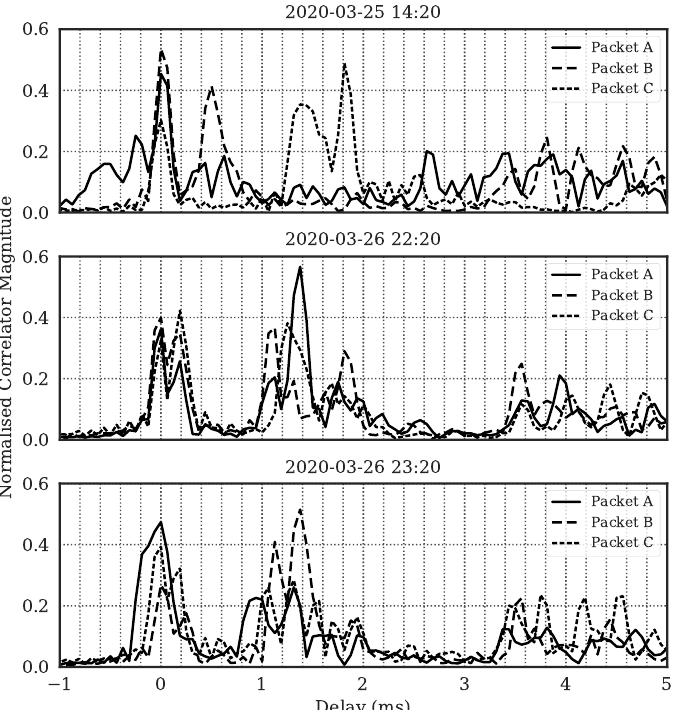
Figure 19. Channel impulse responses for failed messages showing particularly severe multipath